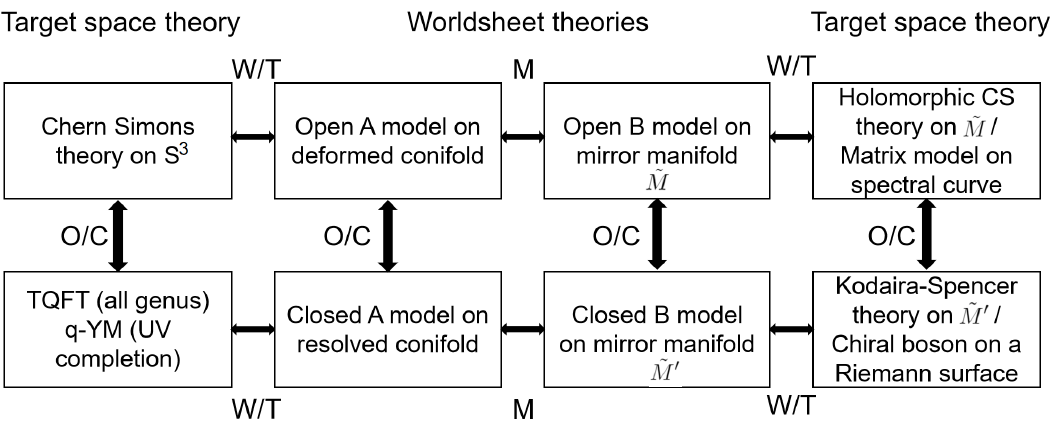
Figure 24 . Web of dualities for topological string theory. W/T: worldsheet/target space duality. O/C: open/closed duality (large N duality); M: mirror symmetry. state associated with the AdS-Schwarzschild geometry. 26 In AdS/CFT, the